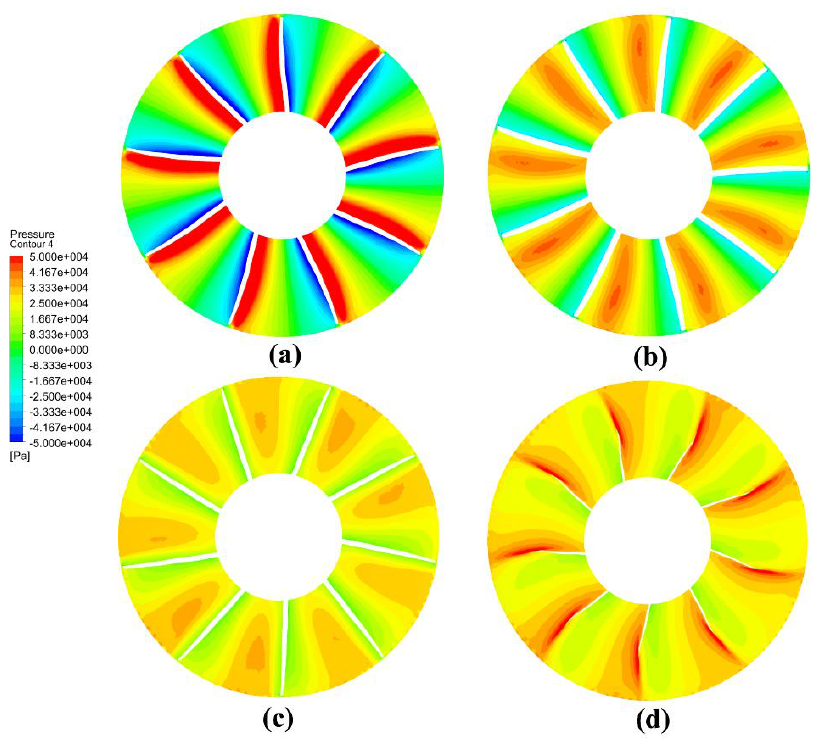
Figure 20. Axial section pressure distribution of rotor designed by lifting method: ( a ) 20% rotor channel, ( b ) 40% rotor channel, ( c ) 70% rotor channel, and ( d ) 90% rotor channel.